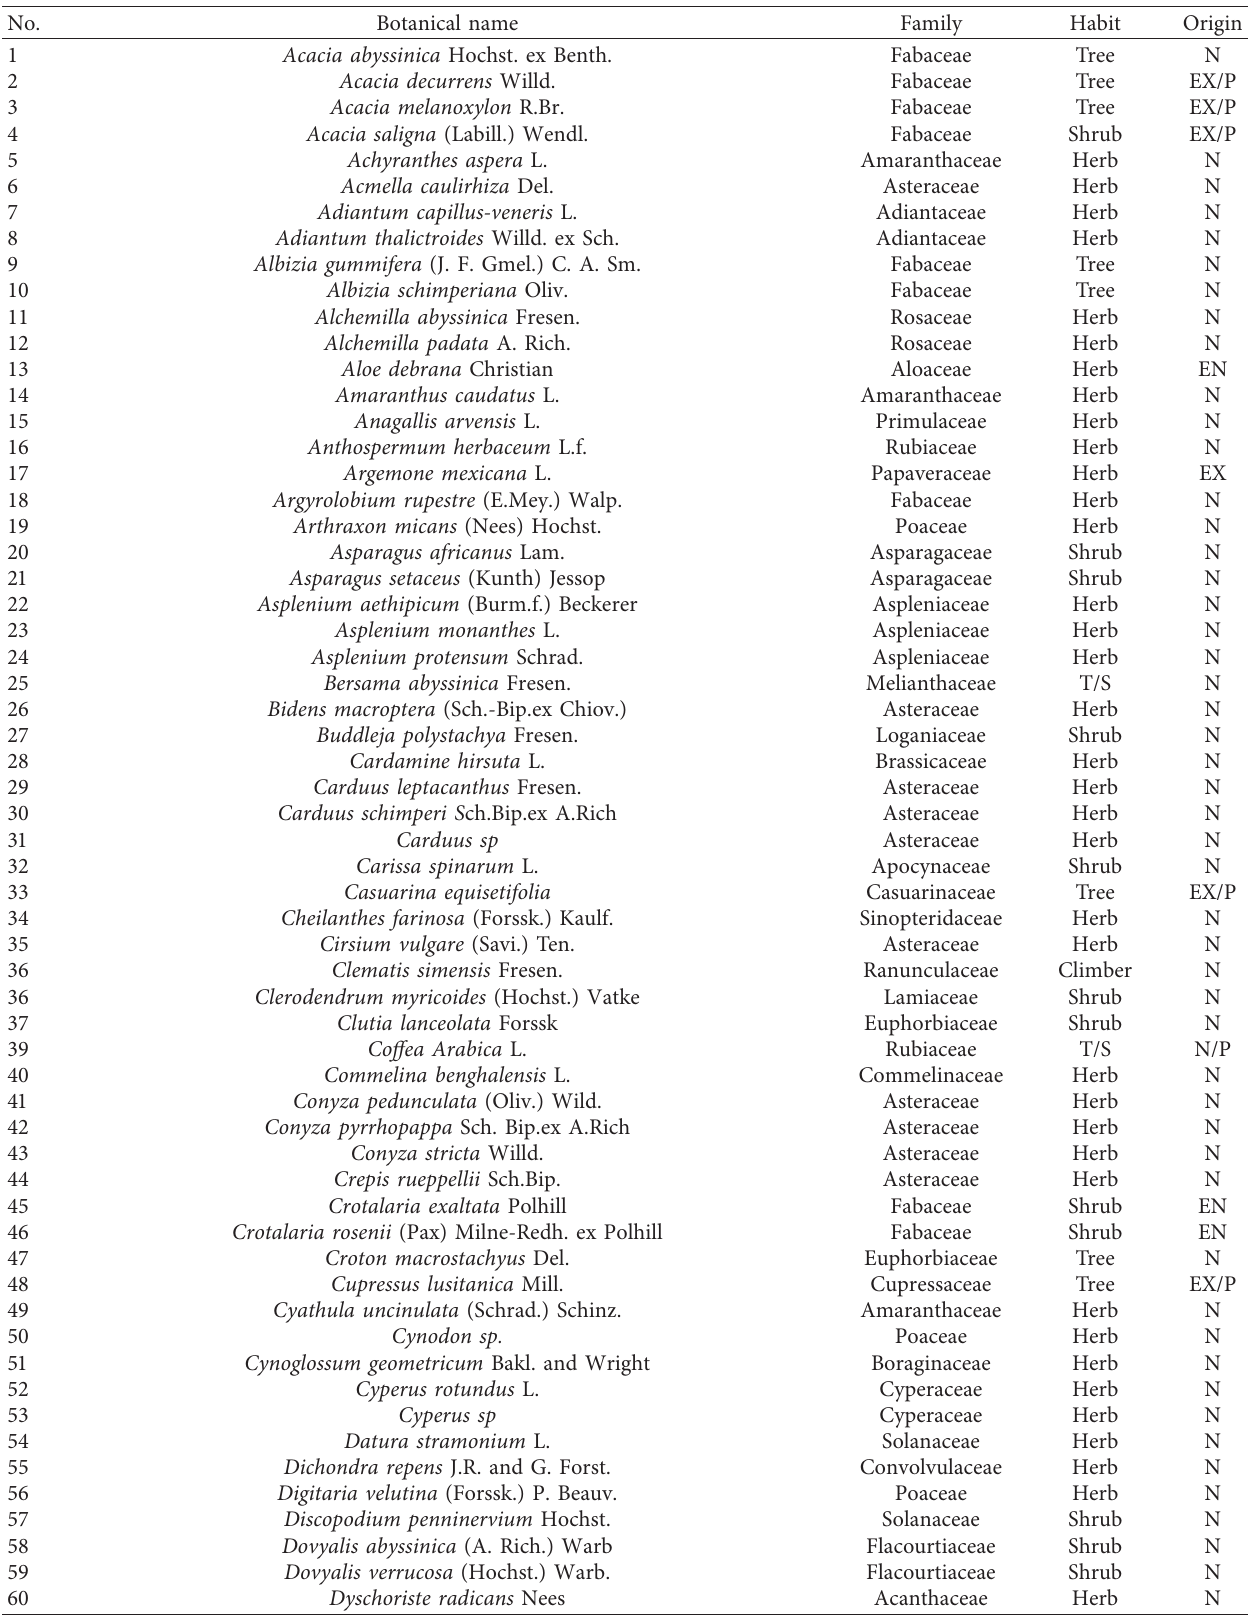
Table 1: List of all plant species, family, and growth habit recorded from the study